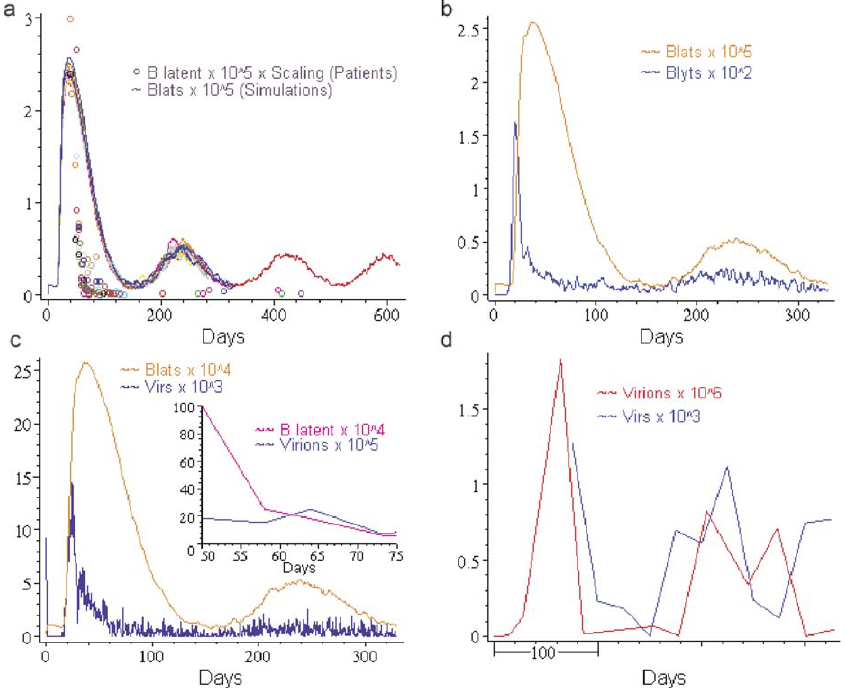
Figure 4. Output of the Simulation Employing the Default Parameter Set Matched to Biological Data (A) Simulation output of the total number of latently infected virtual B cells (B Lat ) over time in a series of superimposed simulation runs (colored lines) versus the number of actual latently infected memory B cells in the peripheral blood of 15 acutely infected individuals over time (colored circles). The first patient time point is assumed to be at 50 d þ / (cid:3) 10 d (see text for explanation). The simulation runs all use the default parameter set. Stochasticity (i.e., random variations) in the runs are a consequence of the fact that every interaction and motion of agents is governed by a probability and a variability function. So, for example, the initial infectious dose will vary from node to node in the epithelium and will have a certain average. This average we refer to as the initial infectious dose. For a detailed discussion of all the rules governing interactions and motion, see M. Shapiro, K. Duca, E. Delgado-Eckert, V. Hadinoto, A. Jarrah, et al. (2007) A virtual look at Epstein-Barr virus infection: simulation mechanism (unpublished data). (B) Simulation output of the total number of latently infected virtual B cells (B Lat ) and virtual B cells replicating virtual virus (B Lyt ) over time for a single simulation run. (C) Simulation output of the level of latently infected virtual B cells (B Lat ) and free virtual virus (Vir) over time for a single simulation run. The insert shows a time course for a typical acutely infected patient for the first 25 d after entering the clinic showing the level of latently infected memory B cells in the peripheral blood and free virions shed into the saliva. (D) The level of virtual free virus (Vir) over 1 y in the simulation (blue line). The level was assessed every 25 d, once the simulation had entered into the persistent phase defined as a stable level of latently infected virtual B cells (B Lat ) For comparison, the level of shed virus (Virions) in the saliva of a persistently infected individual, sampled on average approximately every 30 d, is shown (red line). The x -axis denotes the number of days over which sampling was performed and does not relate to the time from initial infection N.B. Note this figure only allows analysis of overall dynamics, not absolute numbers, since all comparisons between simulation and in vivo data are relative.